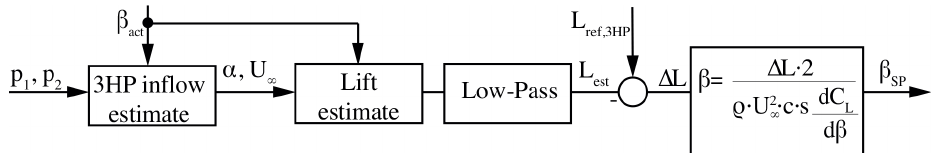
Figure 11. Feedforward controller based on the three-hole probe lift estimate. The first two blocks corresponds to the lift estimation presented in Sect. 3.1. The flap angle set point is calculated based on the error in reference to a 10s mean. The latter is also based on three-hole probe